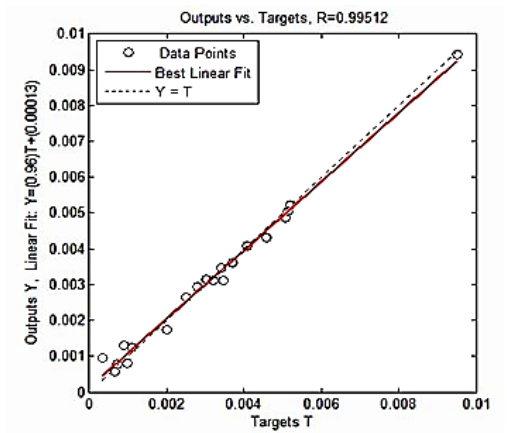
Figure 12. Regression plot of actual and network’s TWR .